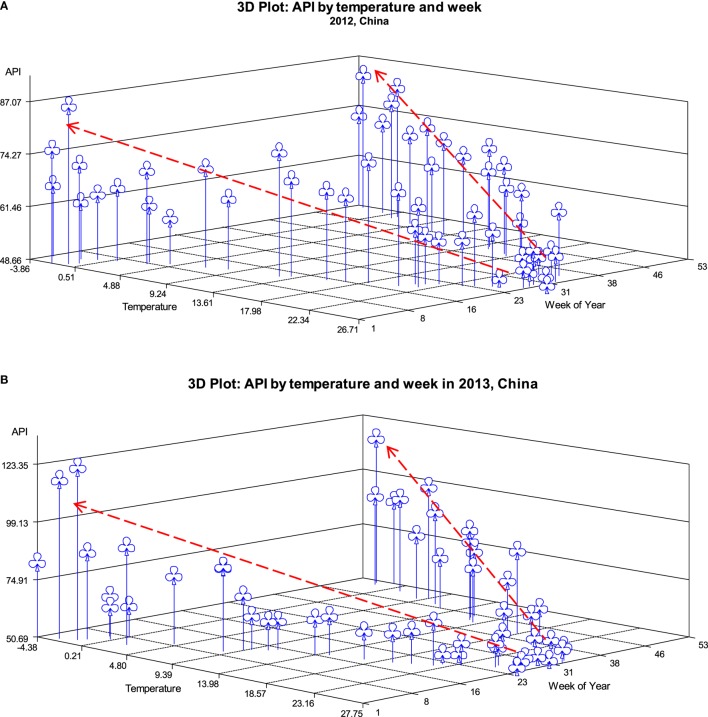
Mean API by temperature and weeks in 2012 (A) and 2013 (B).